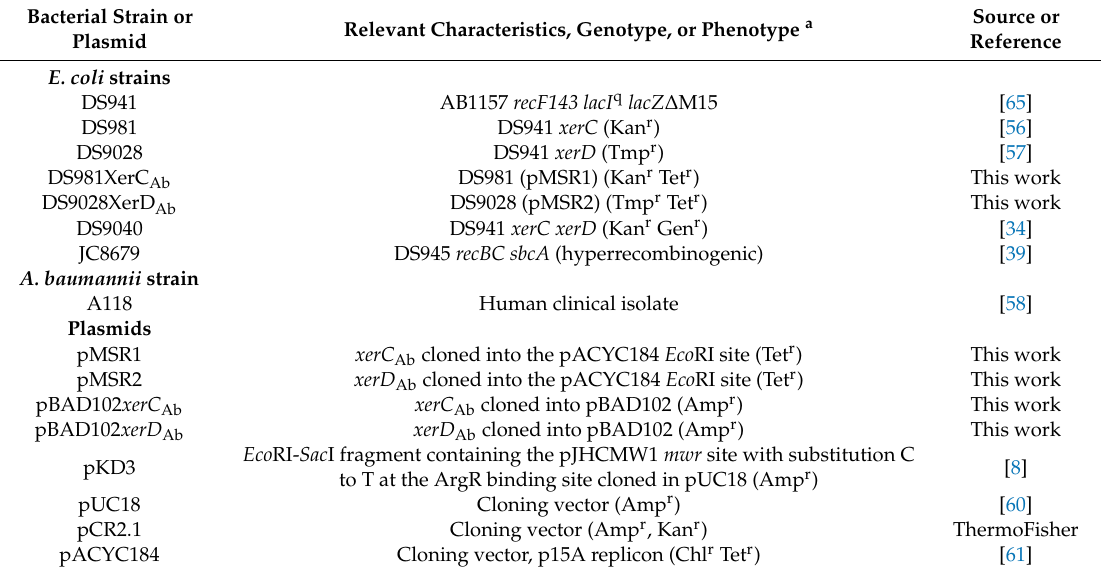
Table 2. Bacterial strains and plasmids used in this study. Bacterial Strain or Relevant Characteristics, Genotype, or Phenotype a Plasmid